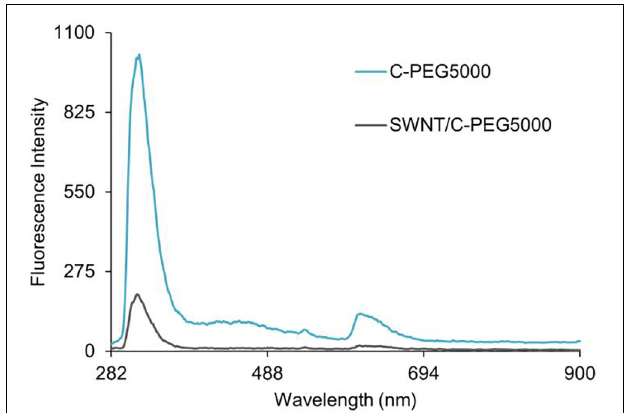
FIGURE 9 | Thermogravimetric results of bare SWNTS and SWNTs coated with G-PEGs, W-PEGs, and